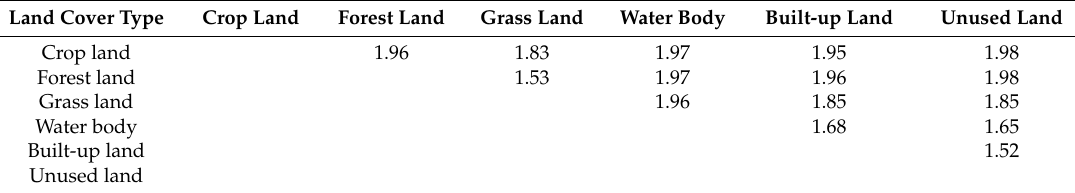
Table 2. J-M distance between different land cover types after HANTS